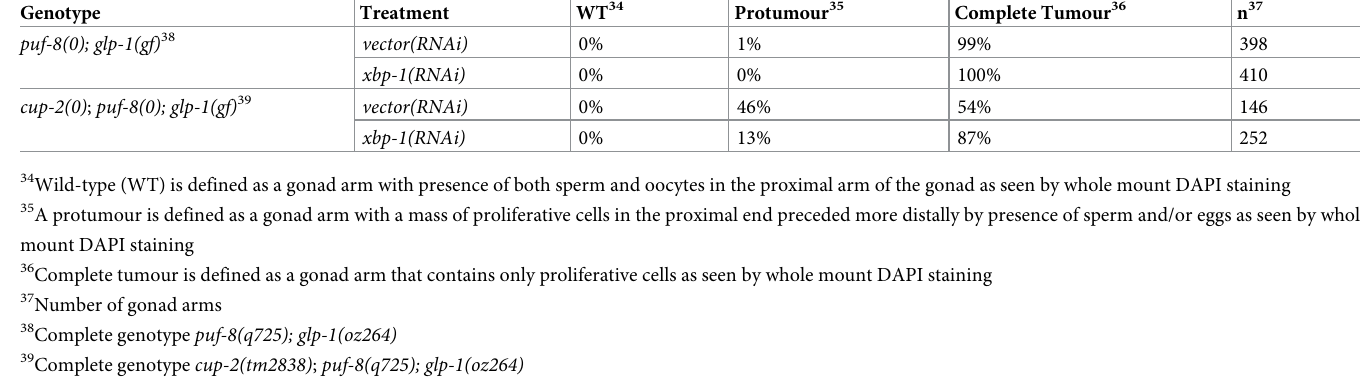
Table 7. Reduction in xbp-1 function partially enhances glp-1(gf) overproliferation when also lacking cup-2 activity. Genotype